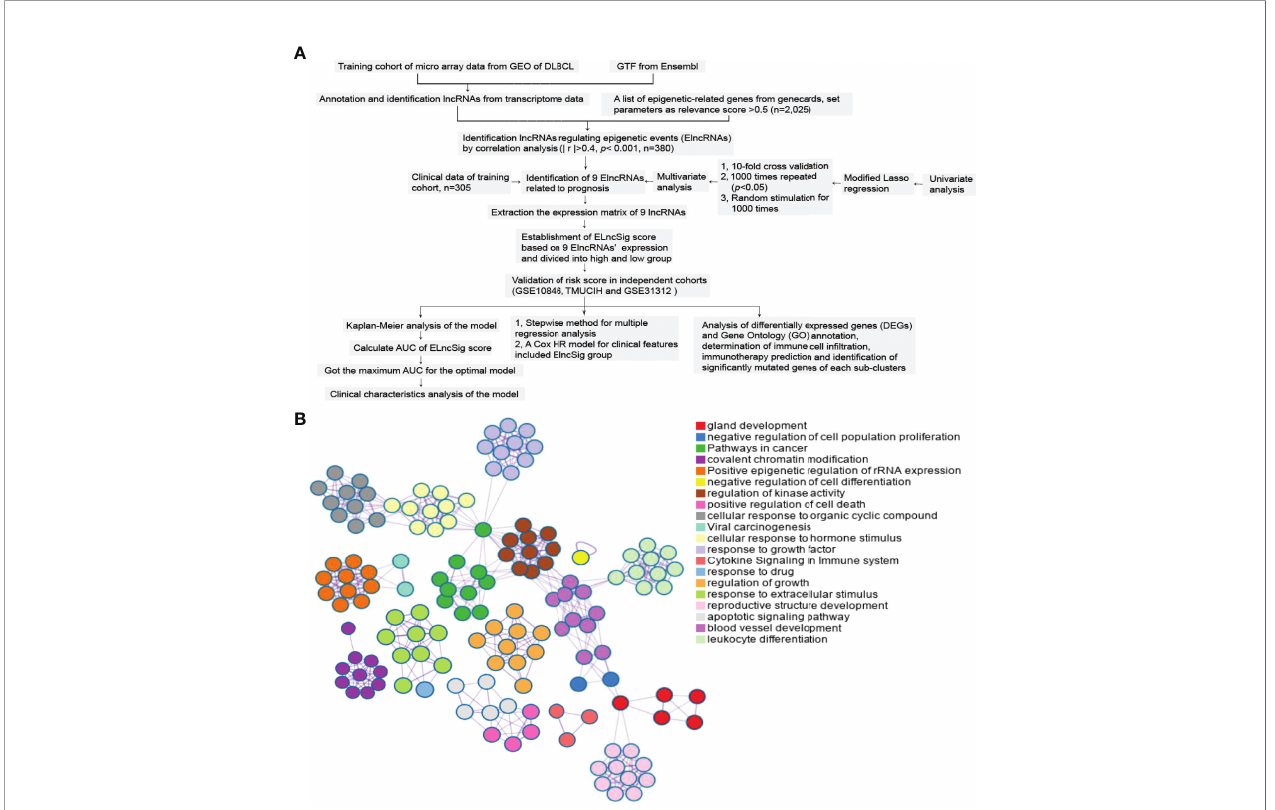
FIGURE 1 | Study fl owchart and epigenetic-related gene enrichment pathways. (A) The work fl ow of the study. (B) Different colors indicate the 2,025 epigenetic- related gene annotations and biological processes provided by